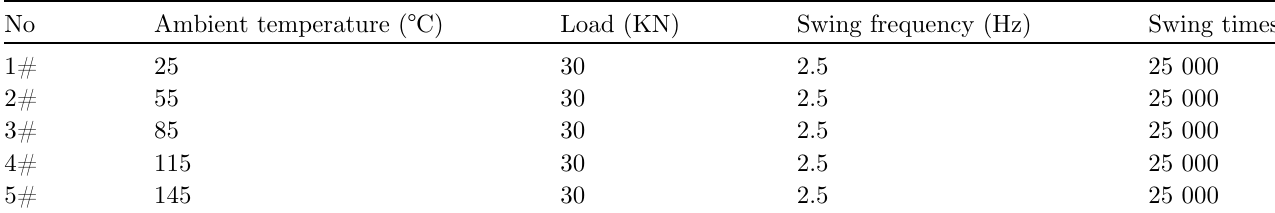
Table 1. Friction and wear test